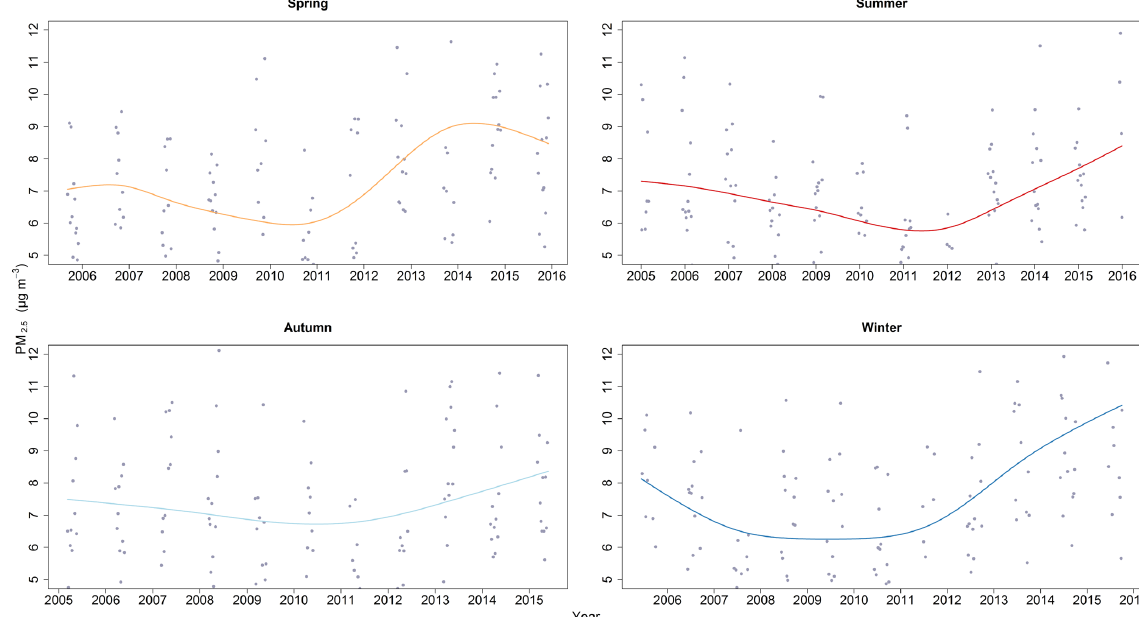
Figure 4. Annual trends in the weekly mean concentrations of PM 2 . 5 in Sydney, split by season for